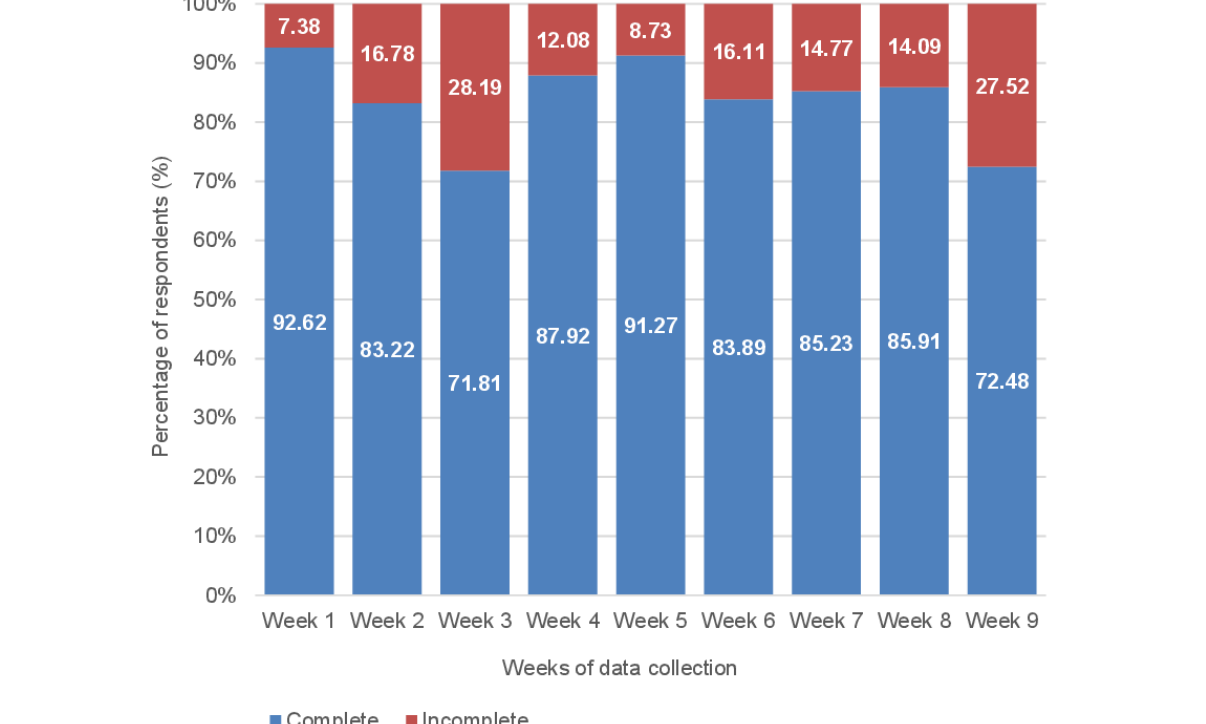
Figure 1. Compliance with diary completion